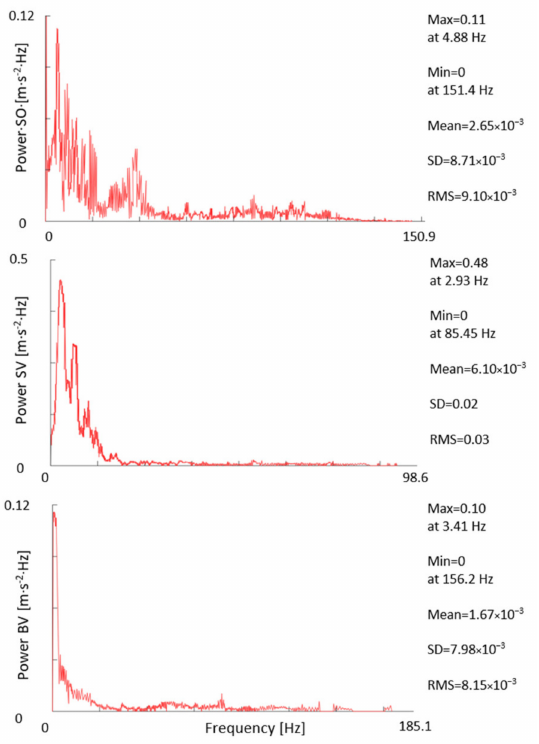
Figure 10. Power spectrum of vibrations during sowing on plot P2 at the working speed of 4 km · h − 1